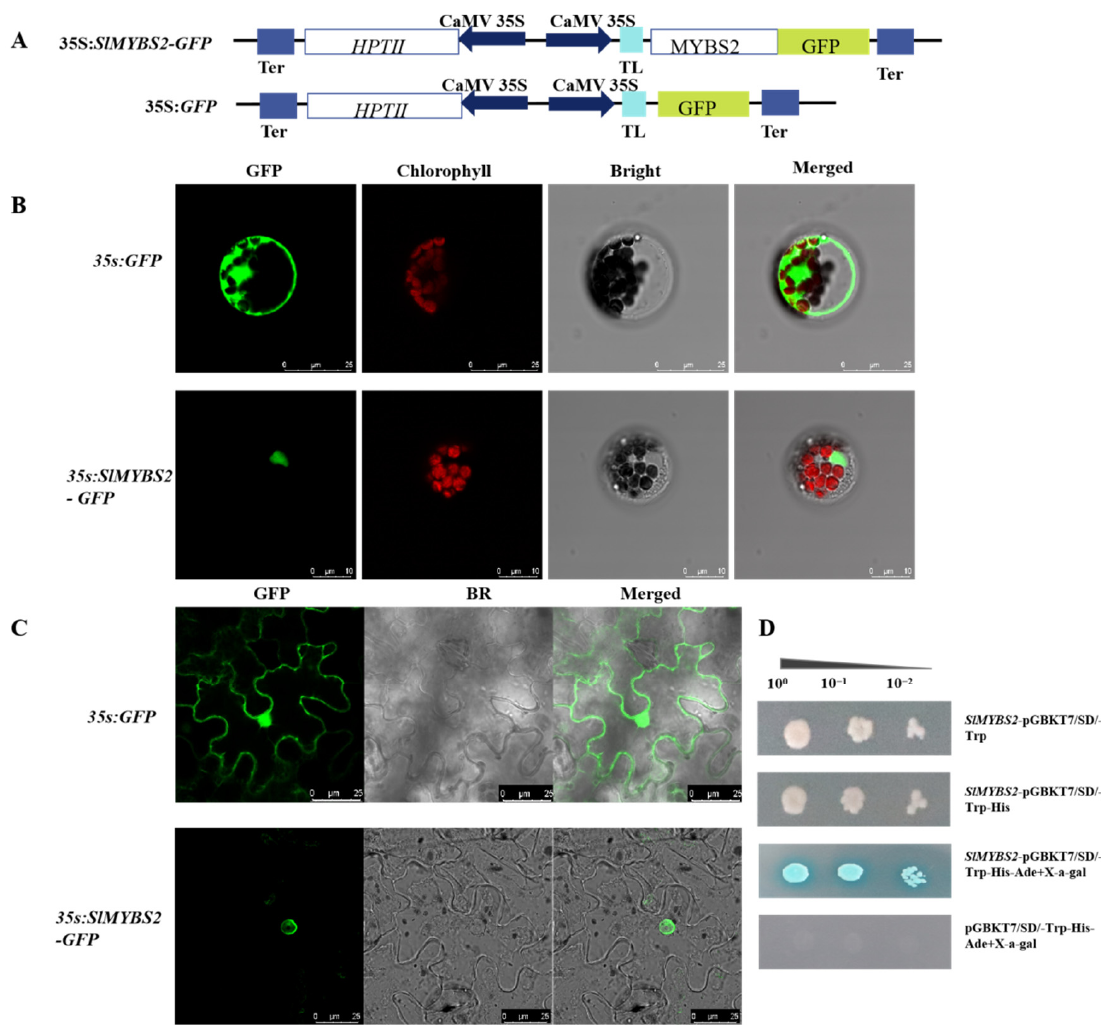
Figure 2. Subcellular localization and transcriptional activity analyses of SlMYBS2 . ( A ) Schematic diagrams of the T-DNA regions of constructs used in the subcellular localization assay. HPTII , hygromycin-resistant gene. ( B , C ) Localization of SlMYBS2 in A. thaliana and Nicotiana benthamiana cells (35S:GFP as the control group, 35S: SlMYBS2 -GFP as the experimental group). In each panel, the extreme left box shows GFP fluorescence, the second box shows chlorophyll fluorescence, and the third bright-field box and the right box show an overlay of the two images, as indicated at the top of the image. ( D ) Analysis of the transcriptional activity of SlMYBS2 using a yeast system.